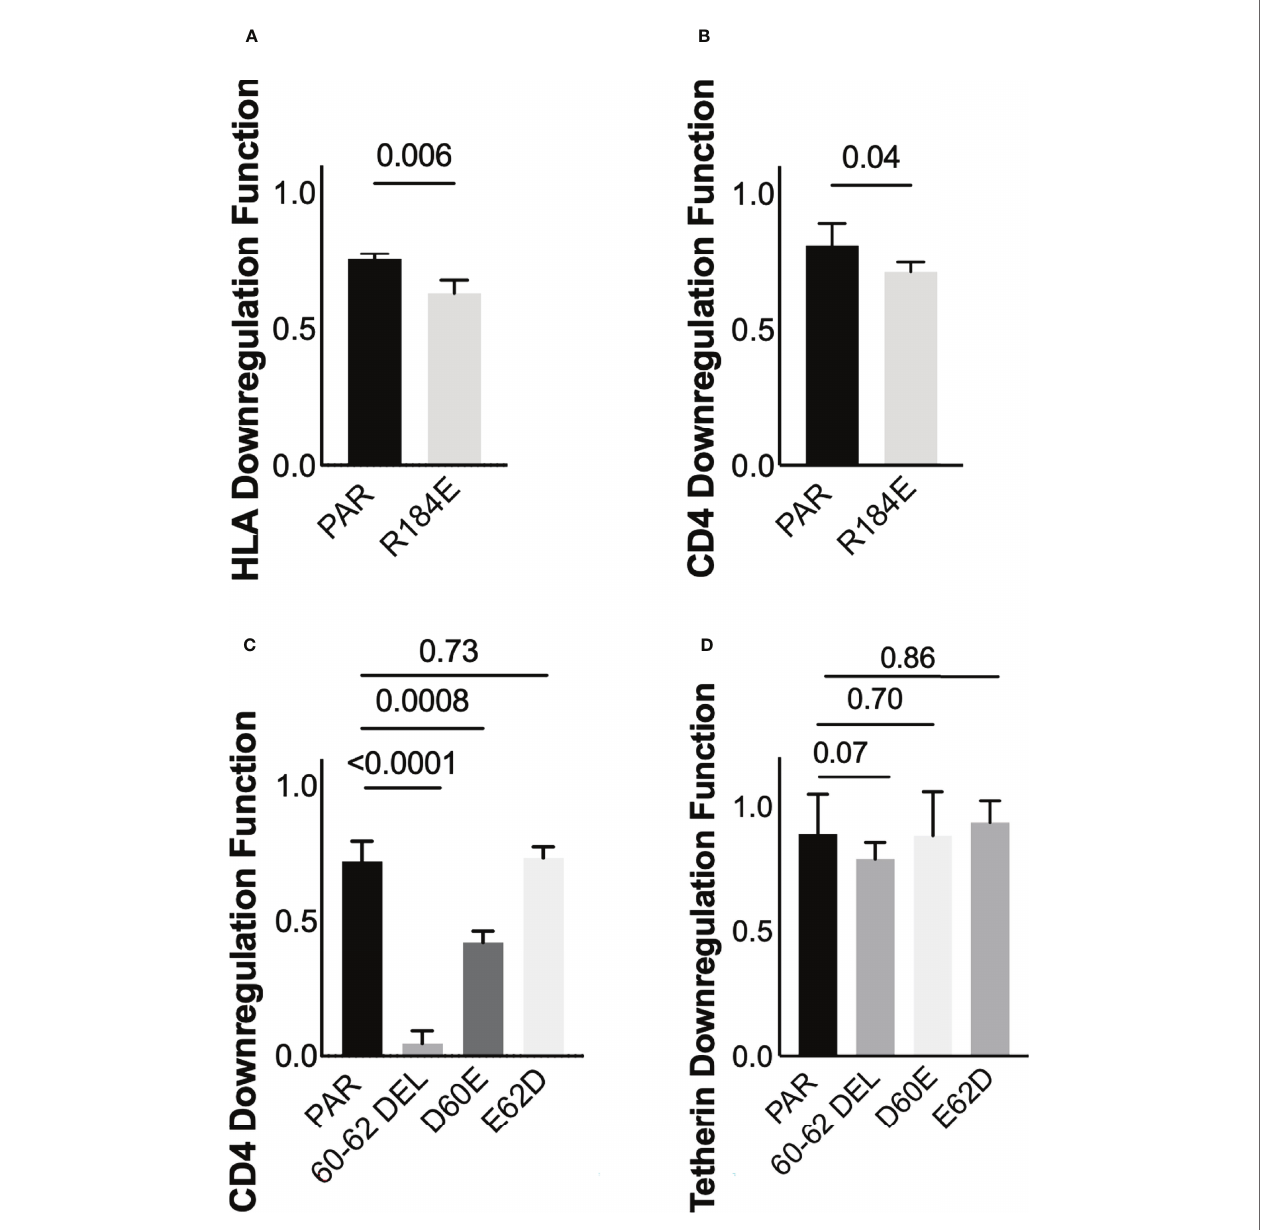
FIGURE 7 | Veri fi cation of residues associated with Nef and Vpu functions (A) Nef-mediated HLA downregulation function of the parental (PAR) clone expressing R184, and the mutant harboring R184E. Results are expressed as mean of 3 replicate measurements with error bars denoting the median and interquartile range. (B) Same as A, but for Nef-mediated CD4 downregulation function (C) Vpu-mediated CD4 downregulation function of the parental (PAR) clone expressing D60 and E62, along with mutants harboring the 60-62 deletion, D60E or E62D substitutions (D) Same as C, but for Vpu-mediated Tetherin downregulation